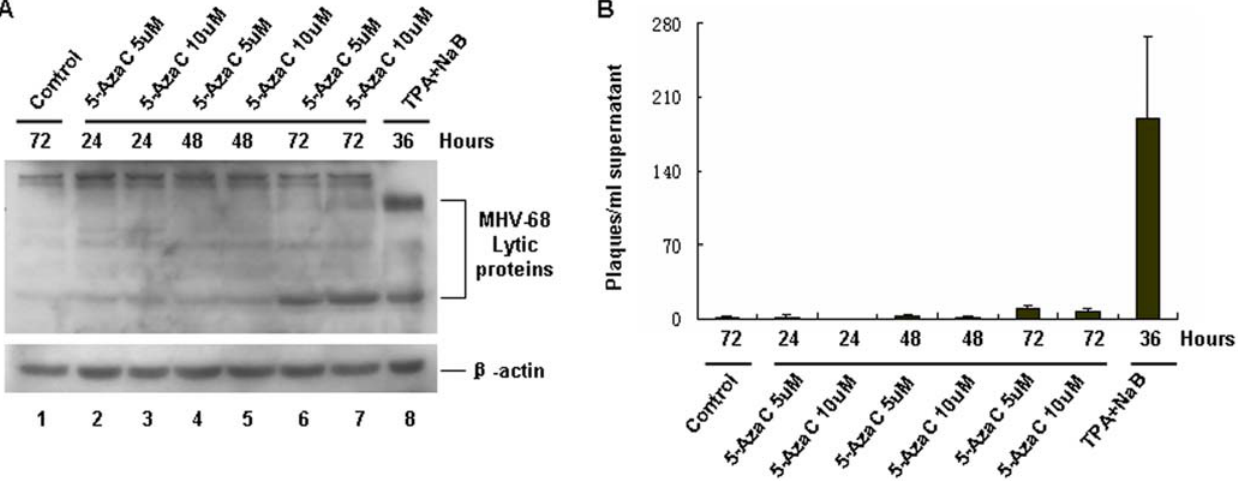
Figure 1. 5-AzaC treatment of S11E cells induced weak MHV-68 lytic replication. (A) Detection of MHV-68 lytic protein by western blotting after S11E cells were induced by 5-AzaC. S11E cells were treated with 5 m M or 10 m M 5-AzaC for 24, 48 or 72 hrs, then cells were lysed and viral lytic proteins detected using a polyclonal antibody against MHV-68 lytic antigens. TPA (25 ng/ml) plus NaB (4 mM) treatment served as a positive control. (B) Supernatants from induced S11E cells were collected, and plaque assay were performed to detect viral titers. The experiments were repeated three times and standard deviations were expressed as error bars.